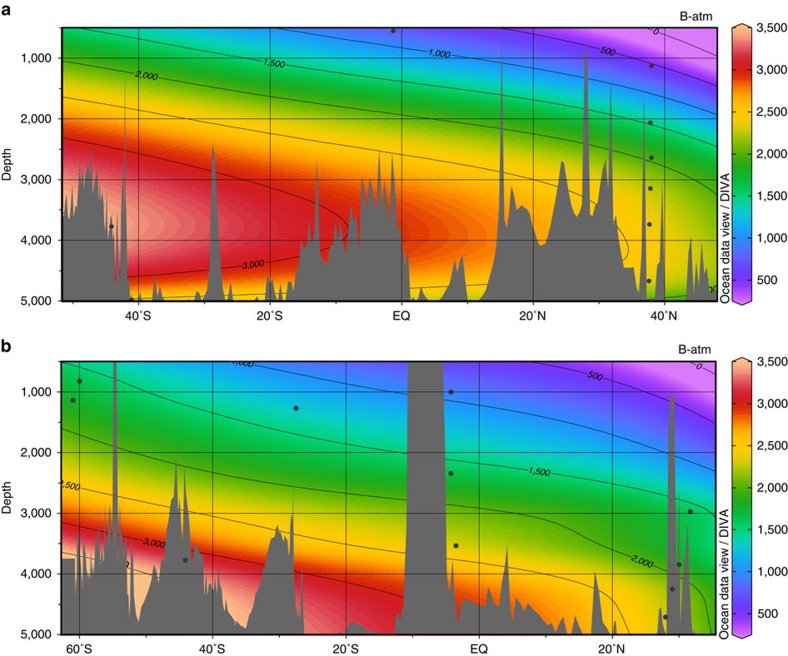
Atlantic radiocarbon based ventilation ages at the LGM.(a) Eastern Atlantic. (b) Western Atlantic181920212223242534. MD07-3076Q (44°S, 14°W, 3770, m) is included in both the eastern and the western profiles as it is located on the Mid-Atlantic Ridge. The dots indicate the position of the cores where ventilation ages have been determined. Gridded in ODV71 using DIVA gridding with a signal-to-noise ratio of 72. Data are given in Supplementary Table 4.